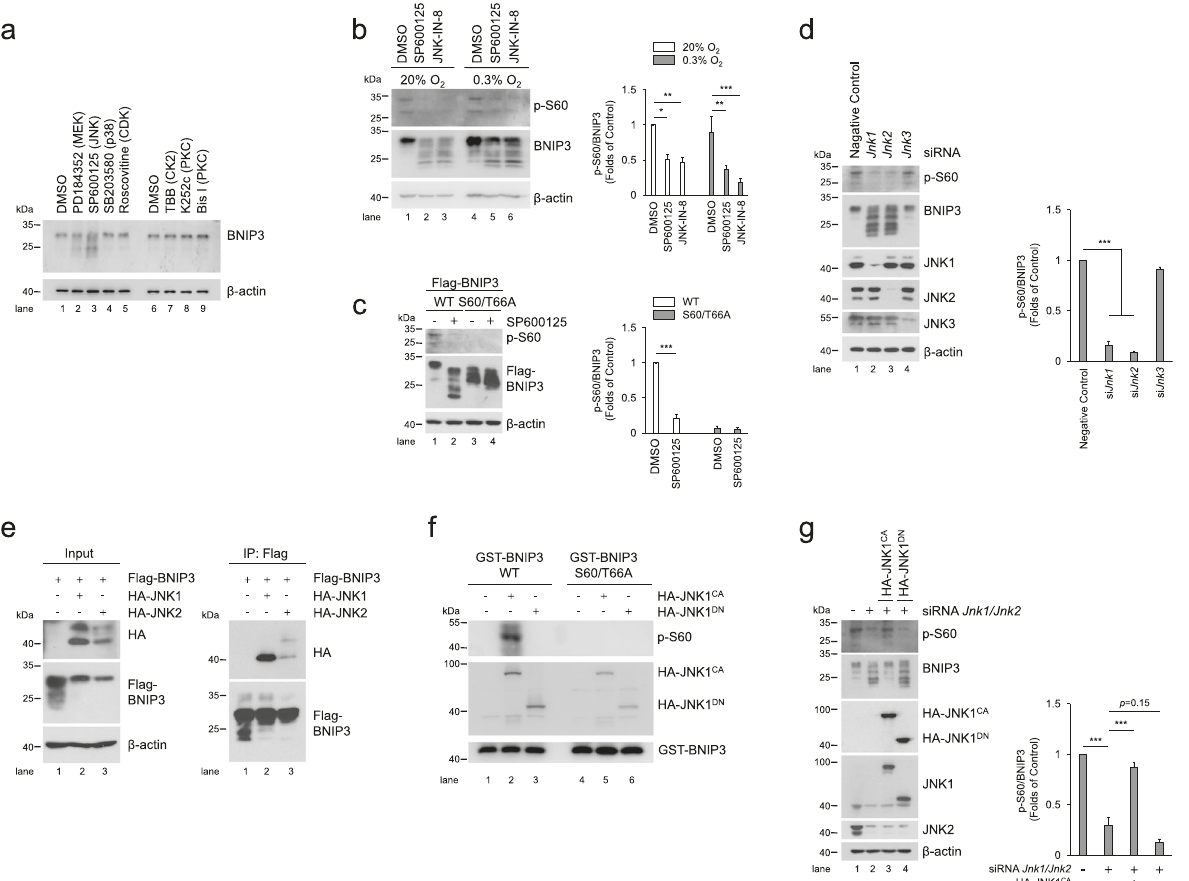
Fig. 5 JNK1/2 is the kinase responsible for BNIP3 phosphorylation. a PC12 cells were treated with various kinase inhibitors, including 10 μ M PD184352 (MEK inhibitor), 10 μ M SP600125 (JNK inhibitor), 10 μ M SB203580 (p38 inhibitor), 10 μ M Roscovitine (CDK inhibitor), 100 μ M TBB (CK2 inhibitor), 10 μ M K252c and 1 μ M Bis I (PKC inhibitor). Then, cell lysates were subjected to western blotting with the indicated antibodies. DMSO, dimethylsulfoxide. b The phosphorylation of BNIP3 was detected via western blotting after PC12 cells were treated with JNK inhibitor SP600125 (10 μ M) or JNK-IN-8 (10 μ M) and exposed to 20% O 2 or 0.3% O 2 for 6 h. n = 3. c PC12 cells stably expressing WT or S60/T66A mutant Flag-BNIP3 were treated with DMSO or SP6000125 and followed by detection of phosphorylation of BNIP3. n = 3. d After Jnk was knocked down with the indicated siRNA in PC12 cells, the levels of JNK protein and BNIP3 phosphorylation were measured by western blotting. n = 3. e HeLa cells were transfected with Flag-BNIP3 and HA-JNK1 or HA-JNK2 for 48 h. Cell lysates were then immunoprecipitated with an anti-Flag antibody and detected by western blotting with an anti-HA or anti-Flag antibody. f Immunoprecipitated constitutively active (CA) HA-JNK1 or dominant negative (DN) HA-JNK1 was incubated with WT or S60/T66A GST-BNIP3 protein at 30 °C for 30 min, and then the reaction products were subjected to western blotting with the indicated antibodies. g Jnk1 and Jnk2 knockdown PC12 cells were transfected with HA-JNK1 CA or HA-JNK1 DN mutants for 48 h, cell lysates were then analyzed via western blotting with the indicated antibodies. n = 3. The data are expressed as means ± SEM. * P < 0.05, ** P < 0.01, *** P < 0.001 versus the indicated BNIP3 phosphorylation may impede its proteasomal degrada- tion. To determine whether phosphorylation at the Ser 60/Thr 66 site is involved in regulation of BNIP3 stability, we measured the effect of the phospho-disabling or phospho-mimic muta- tions of these sites on BNIP3 degradation after HeLa cells were transfected with the mutants and treated with CHX. Our data demonstrated that the S60A and S60/T66A mutants accelerated the degradation of BNIP3, and the S60D and S60E mutants dramatically hampered this process, suggesting that phosphor- (Fig. 1e), which indicates that OA blocks dephosphorylation of ylation at Ser 60/Thr 66 is required for BNIP3 stability (Fig. 3c – f). BNIP3, and more importantly, OA is a potent inhibitor of the protein phosphatases PP1 and PP2A [43], We therefore speculate that PP1 and PP2A may be the phosphatases of BNIP3. Comparing and ubiquitination of BNIP3. As shown in Fig. 3g, the phospho- calyculin A (Cal A) and OA, which are more potent inhibitors of disabling and phospho-mimic BNIP3 mutants were linked with PP1 and PP2A, respectively, we observed both Cal A and OA are all effective in preventing BNIP3 dephosphorylation (Fig. 4a). To determine which catalytic subunit of PP1 or PP2A to play the key role in regulation of BNIP3 dephosphorylation, we found when all